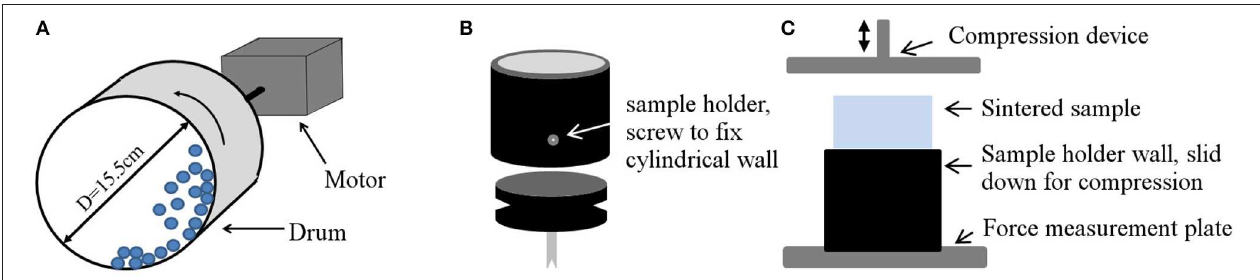
FIGURE 1 | (A) Sketch of the tumbling machine consisting of a cylindrical drum and a rotary motor. (B) Sketch of the sample holder and (C) the experimental set-up for the compression tests.